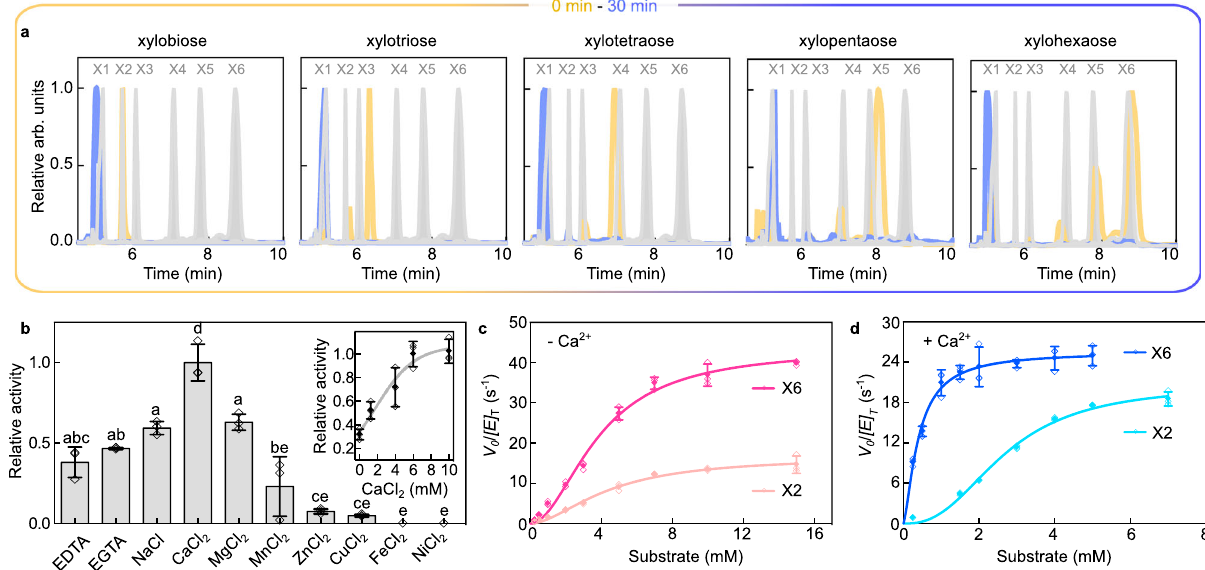
Fig. 2 Catalytic properties of XacGH43_1. a Capillary electrophoresis analysis showing the cleavage pattern of xylobiose, xylotriose, xylotetraose, xylopentaose, and xylohexaose. The reactions were interrupted at 0 min (dark yellow) or 30 min (blue). The standard patterns of xylose (X1), xylobiose (X2), xylotriose (X3), xylotetraose (X4), xylopentaose (X5), and xylohexaose (X6) are shown as gray curves. All data were normalized (starting from 4.5 min to omit APTS signal). b In fl uence of cations and chelating agents in XacGH43_1 activity and the enzyme response with increasing concentrations of CaCl 2 (inset). Results are expressed as mean ± SD from three independent experiments. Data points are shown as empty symbols. In the bars plot, one- way ANOVA ( P < 0.05) and tukey post hoc tests were performed for multiple comparisons ( P < 0.001). Bars showing the same letters do not present signi fi cant statistical difference, according to tukey post hoc test. c Kinetics curves of XacGH43_1 activity on X2 (light pink) or X6 (dark pink) without the addition of CaCl 2 in the reaction. d Kinetics curves of XacGH43_1 activity on X2 (light blue) or X6 (dark blue) with the addition of 6 mM CaCl 2 in the reaction. The ( c, d ) curves were built based on mass spectrometric analysis of xylose release by the enzyme and data are expressed as mean ± SD from three independent experiments (V 0 = initial velocity; [E T ] = enzyme concentration). Data points are shown as empty symbols. Source data are provided as a source data fi